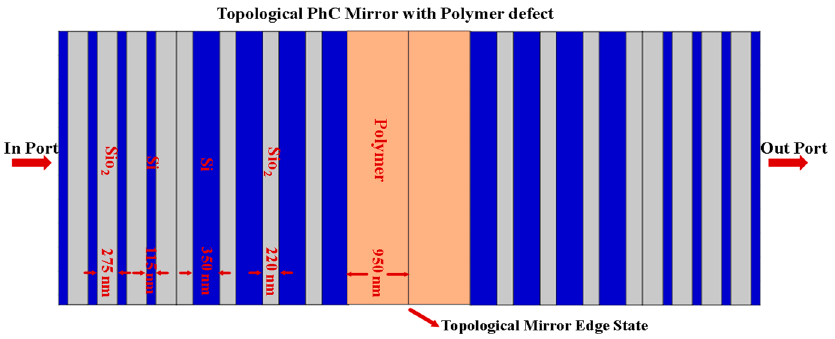
Figure 5. Schematic diagram of the proposed topological PhC mirror heterostructure with EO polymer defect layer.